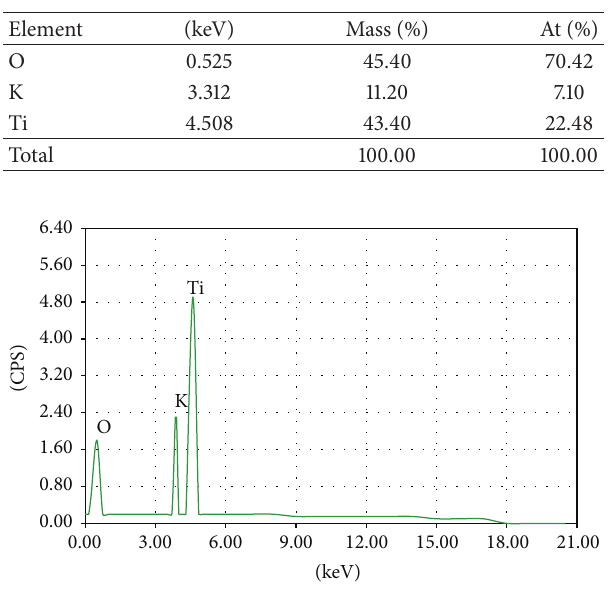
Figure 2: EDAX spectrum of PTW filler.